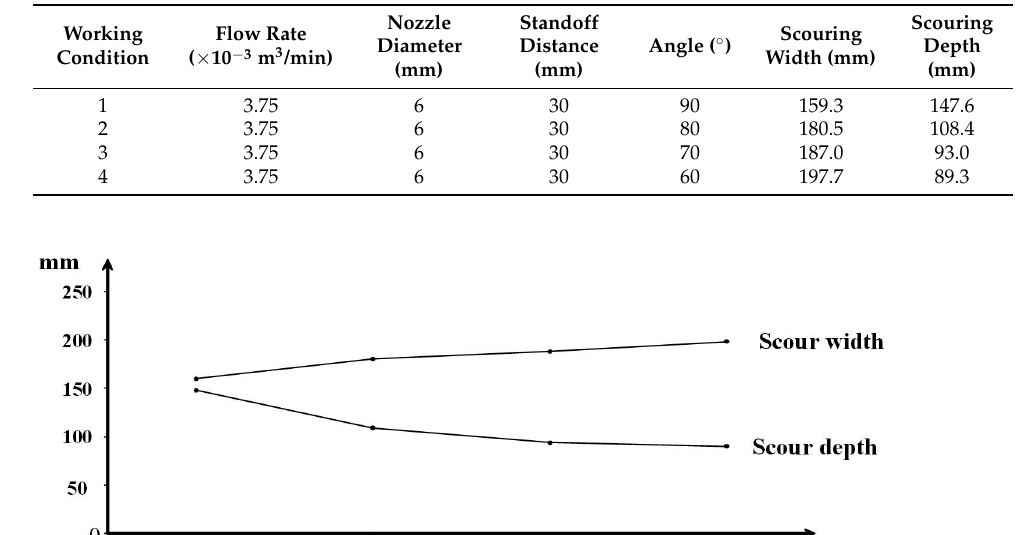
Table 6. Scouring effect at different jet angles.